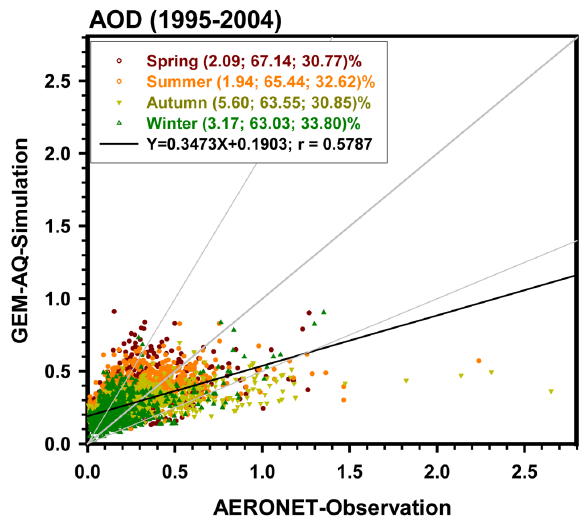
Fig. 7. Correlation between model-simulated AOD and AERONET observations from 1995 to 2004. Scattered dots are grouped into four seasons, each of which shows a different behavior. Dots within the gray area indicate the modeled AODs are within a factor of 2 from observations. The numbers in the bracket following the season are the percentages of modeled results with under-, within a factor of 2 and